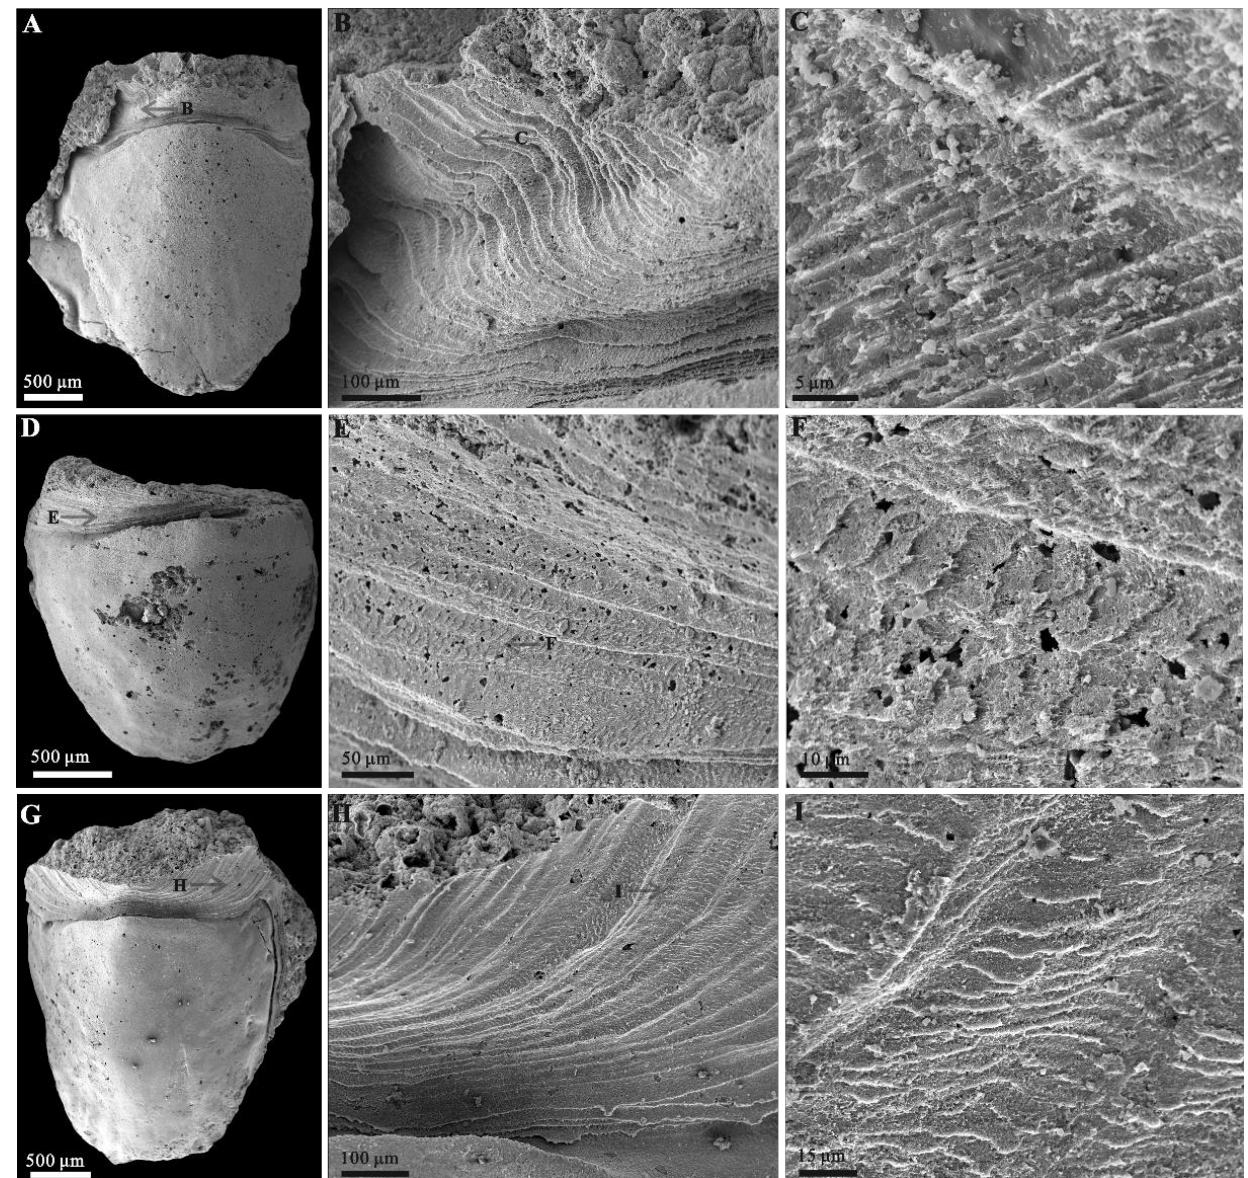
Figure 4. Wrinkles on the extended and upfolded field of Eohalobia sclerites. ( A – C ), ( D – F ), ( G – I ) In- ternal molds; CUBar126 – 12, CUBar126 – 7, CUBar70 – 25, respectively. ( B , E , H ) Magnification of ( A , D , G ), respectively, showing the dense wrinkles on the extended and upfolded field. ( C , F , I ) Magnification of ( B , E , H ), respectively, showing thin fibers and laths on wrinkles. Arrows show position of enlarged areas. The stepwise texture occurs in areas near the lateral and distal margins (Figure